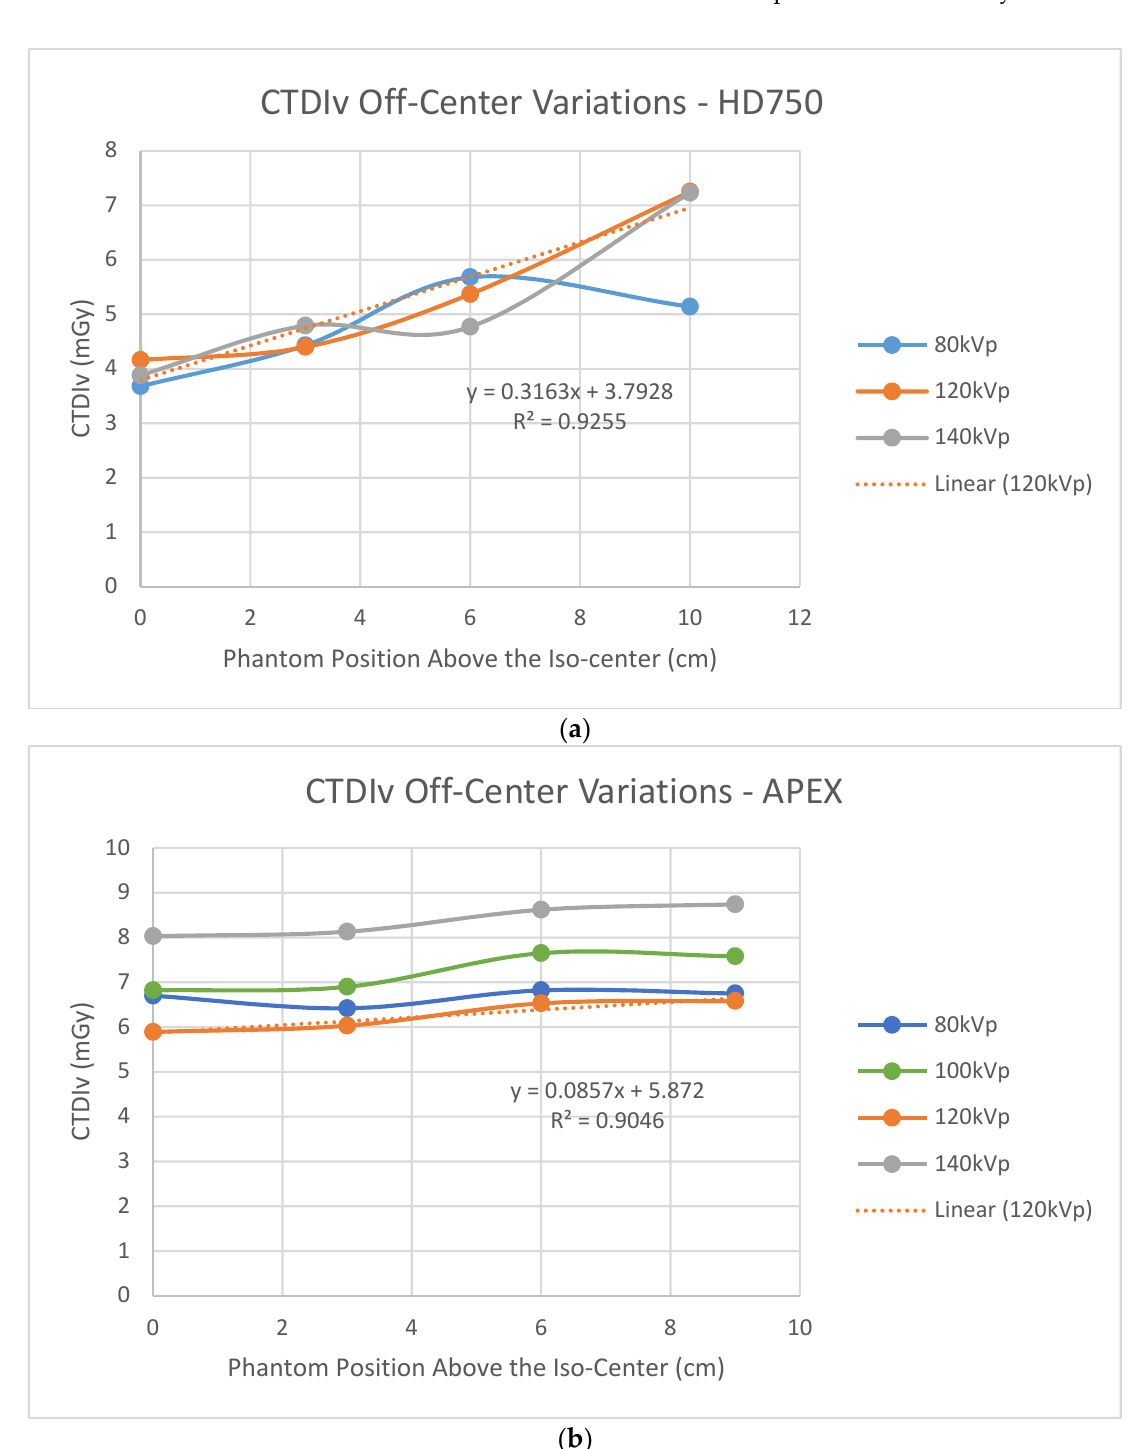
Figure 2. Off-center variations of dose index CTDIv; ( a ) the Discovery HD750 scanner using the PBU60 phantom; ( b ) the Revolution APEX scanner using the 062M phantom.